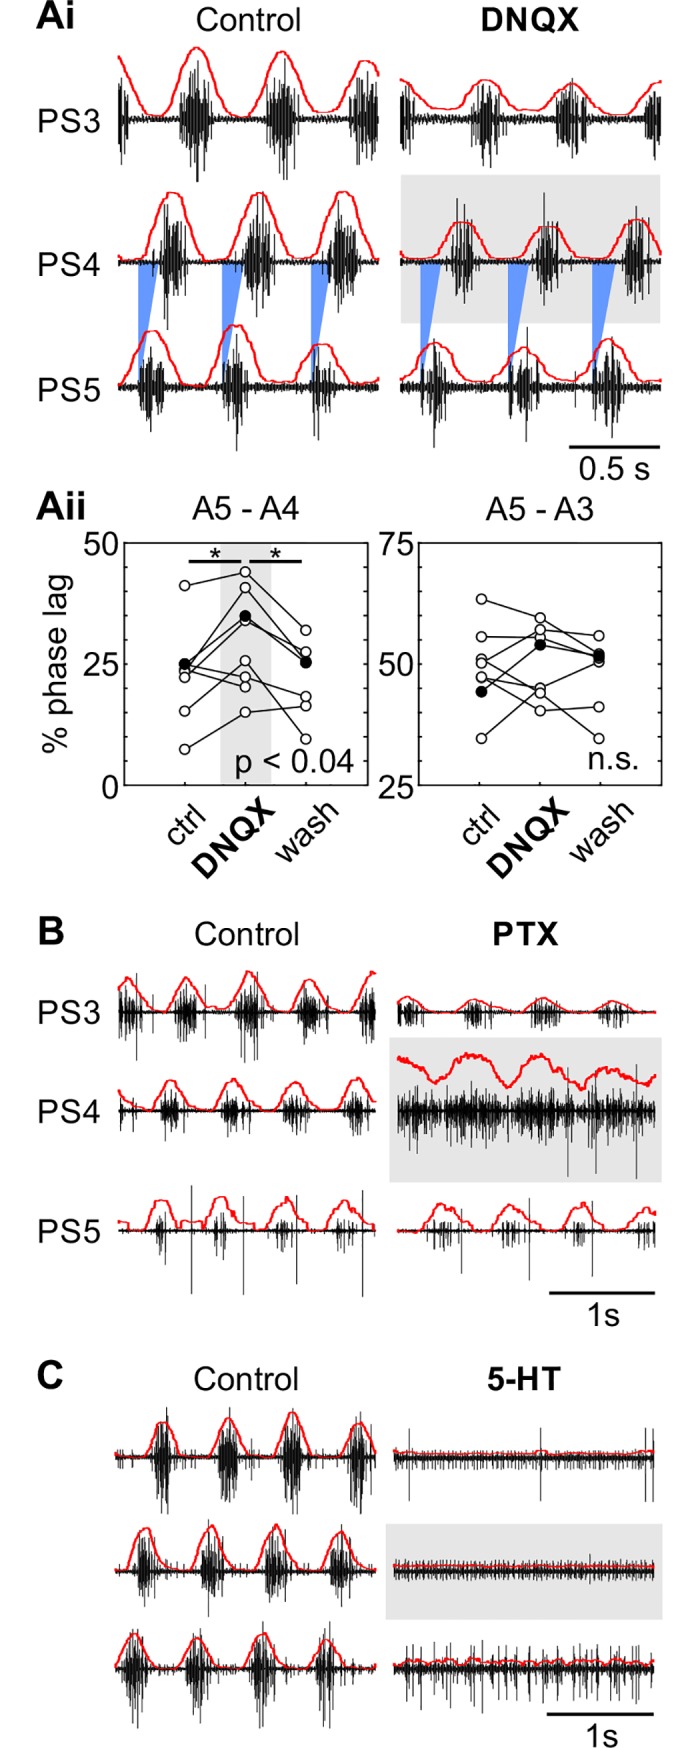
Glutamate antagonists, GABA antagonists, and 5-HT affected intersegmental coordination and rhythmic activity.Raw PS recordings are shown in black, rectified and smoothed recordings are superimposed as red lines. The pharmacological agents were applied to one segment only, shown here with a grey box. A: Phase lag of power-stroke (PS) activity in ganglion A4 without and with DNQX application (grey box). Ai: PS activity in three ganglia of the same preparation. In control condition (left) all motor bursts were properly coordinated. When the glutamate antagonist DNQX (6μM) was perfused over ganglion A4 (grey box) its PS was delayed with respect to PS5 (right). Blue triangles indicate 25% phase lag with respect to PS5. Aii: Mean phase lag of PS activity in ganglion A4 and A3 before, during, and after application of the glutamate antagonist DNQX to A4 (grey background) in eight different preparations. Individual experiments are connected with lines. During DNQX perfusion, the phase lag of A4 increased in 6 of 8 experiments (F(2,12) = 8.095, p < 0.01). After wash-out, the phase lag recovered in 5 of 7 experiments. No rhythmic activity could be recorded in 1 of 8 experiments after washing. The phase lag between the untreated ganglia A5-A3 did not change significantly. Filled circles highlight data from the experiment in Ai. See also S1 Table. B: PS activity recorded from three different ganglia of the same preparation without and with PTX application. In control condition (left), the bursting activity in each segment is clearly distinguishable. The coordinated activity starts in the posterior segment and the other follow with approximately 25% phase lag. When the GABA antagonist PTX (400μM) was perfused over ganglion A4 (grey box) its PS became tonic (right). This tonic activity was still modulated on a cycle-by-cycle basis (red line). Coordination between untreated ganglia was unaffected. C: PS activity recorded from three different ganglia of the same preparation without and with 5-HT application. In control condition (left), the bursting activity in each segment is clearly distinguishable. The coordinated activity starts in the posterior segment and the others follow with approximately 25% phase lag. When 5-HT (500 μM) was perfused over ganglion A4 (grey box) bursting activity ceased in all ganglia (right). All data and statistics for these experiments are in S1 Table.